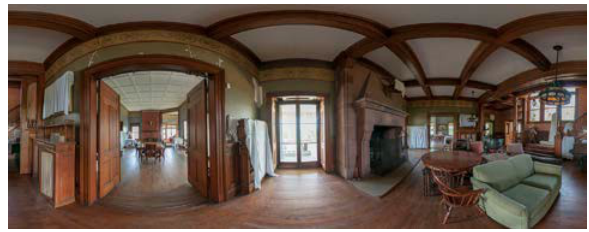
Fig.6 – Full spherical panoramic image of the main